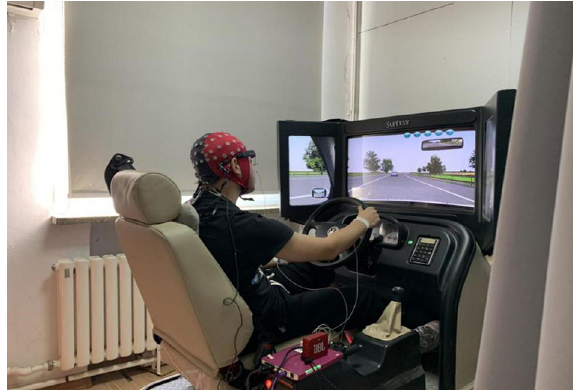
Figure 1. Driving tasks and simulated driving